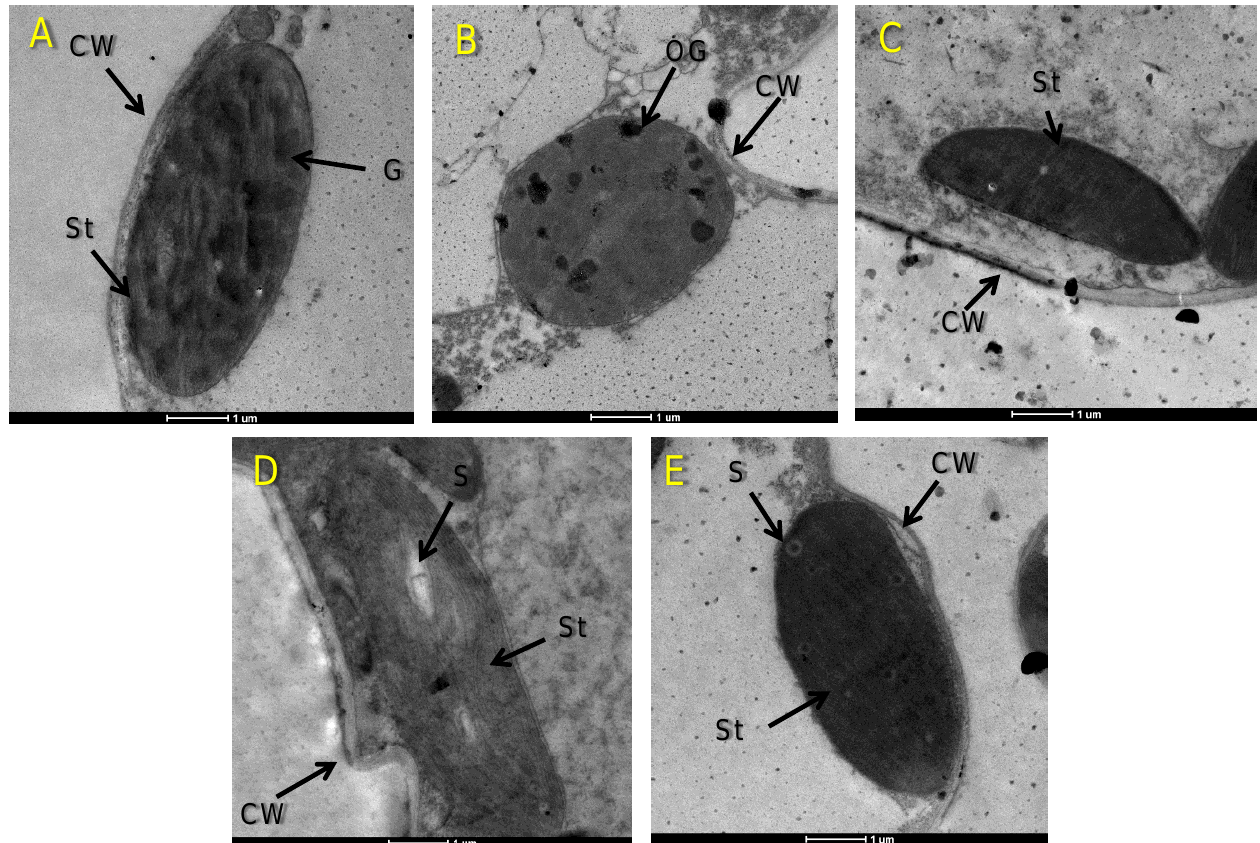
Figure 3. Ultrastructure of the chloroplasts of maize seedlings after exogenous supplementation with L-arginine under drought stress conditions. CW, cell wall; St, stromal thylakoid; OG, osmium granule; S, starch grain. ( A ): control treatment; ( B ): 20% PEG; ( C ): 20% PEG + 150 µ mol L − 1 of L-arginine; ( D ): 25 µ mol L − 1 of L-NAME; ( E ): 20% PEG + 25 µ mol L − 1 of L-NAME. L-NAME, N γ -nitro-L-arginine methyl ester; PEG, polyethylene glycol.